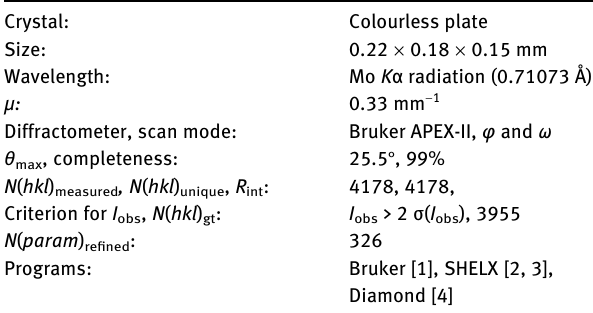
Table  : Data collection and